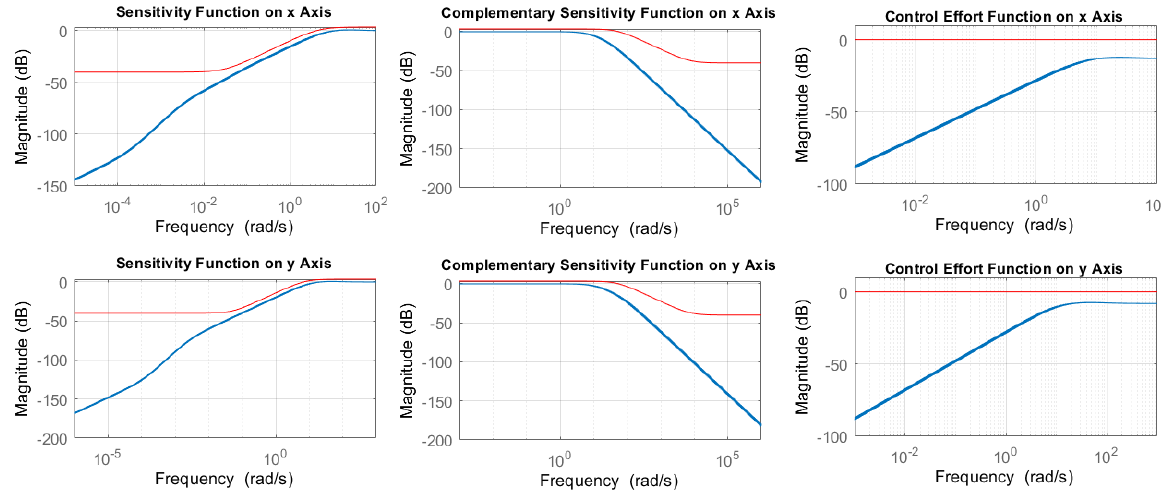
Figure 6. Imposed shapes of the sensitivity, complementary sensitivity and control effort frequency responses for both axis, along with 100 Monte Carlo simulations with actual FO - PI closed-loop